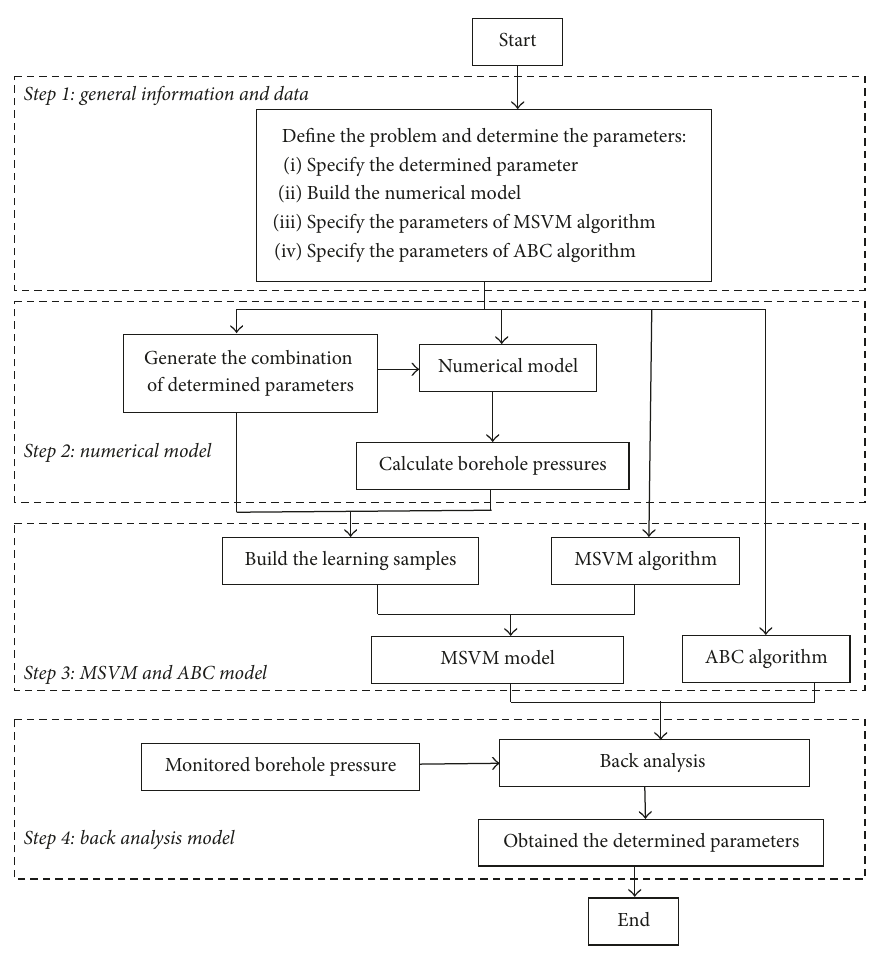
Figure 1: Flowchart of the back analysis process to obtain the rock